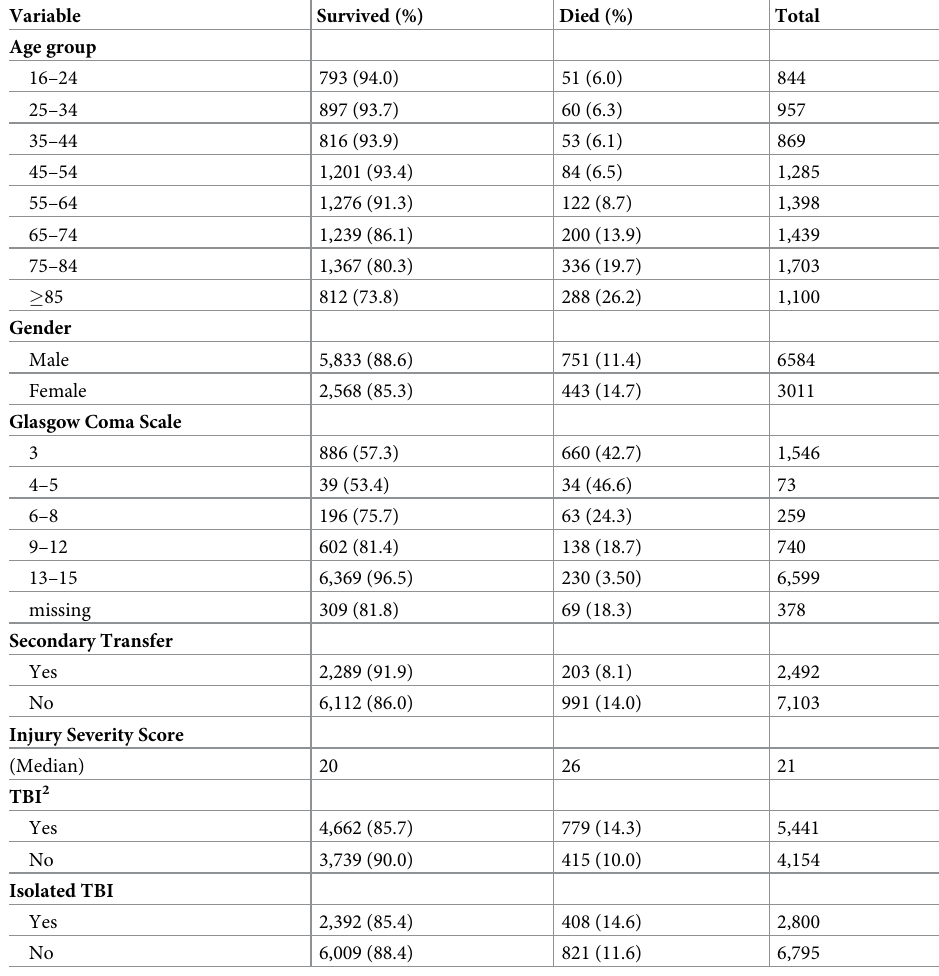
Table 1. Baseline characteristics of study